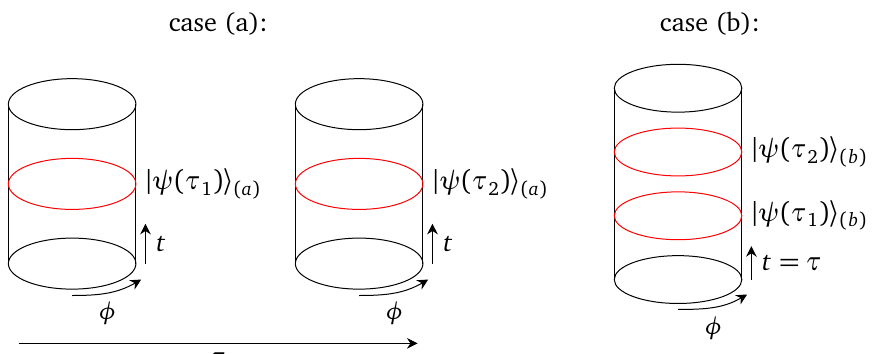
Figure 1: Depiction of the two circuits we consider. In case (a), the circuit evolution proceeds through a sequence of states living on time slices of different spacetimes (marked in red). There is no associated evolution with respect to physical time t . In case (b), the states live on different time slices of the same spacetime. In holography, in case (a) we have a sequence of independent gravity dual geometries, whereas in case (b) we arrive at a single gravity dual